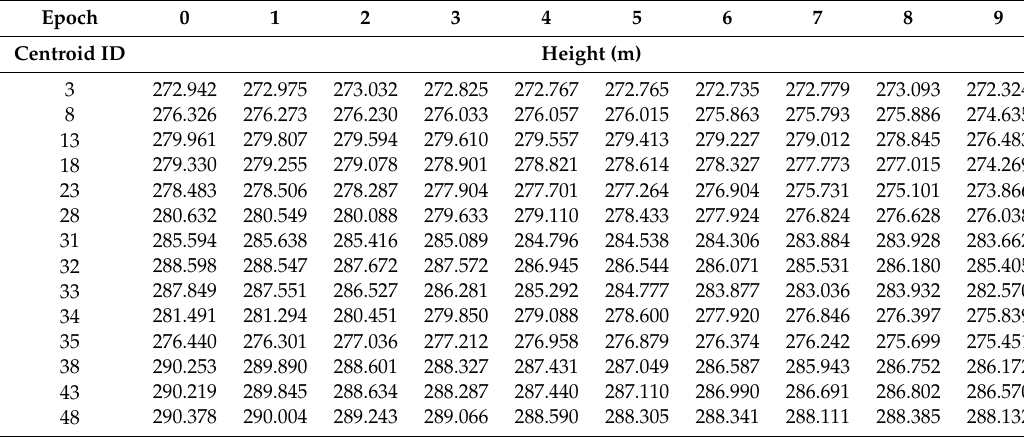
Table 4. Heights of the calculated centroids on profiles Cw7 and CL3.